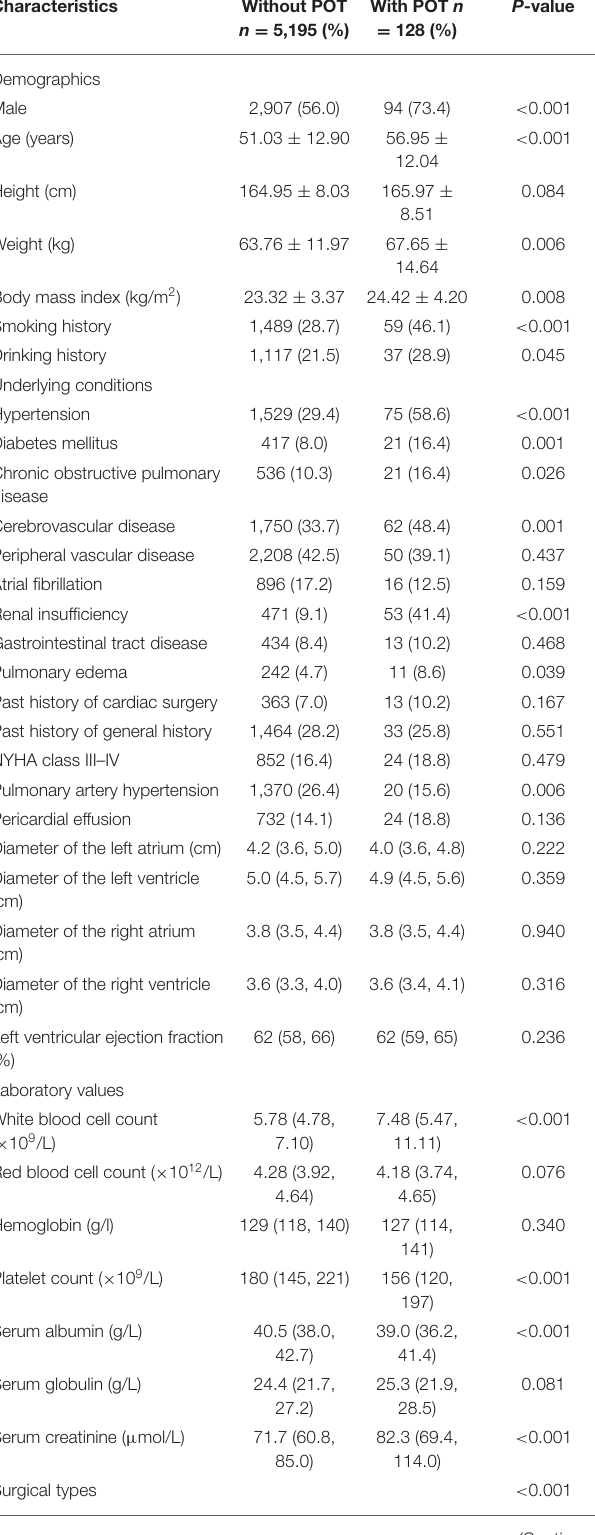
TABLE 1 | Univariable analysis of possible risk factors for POT after cardiac surgery. Characteristics